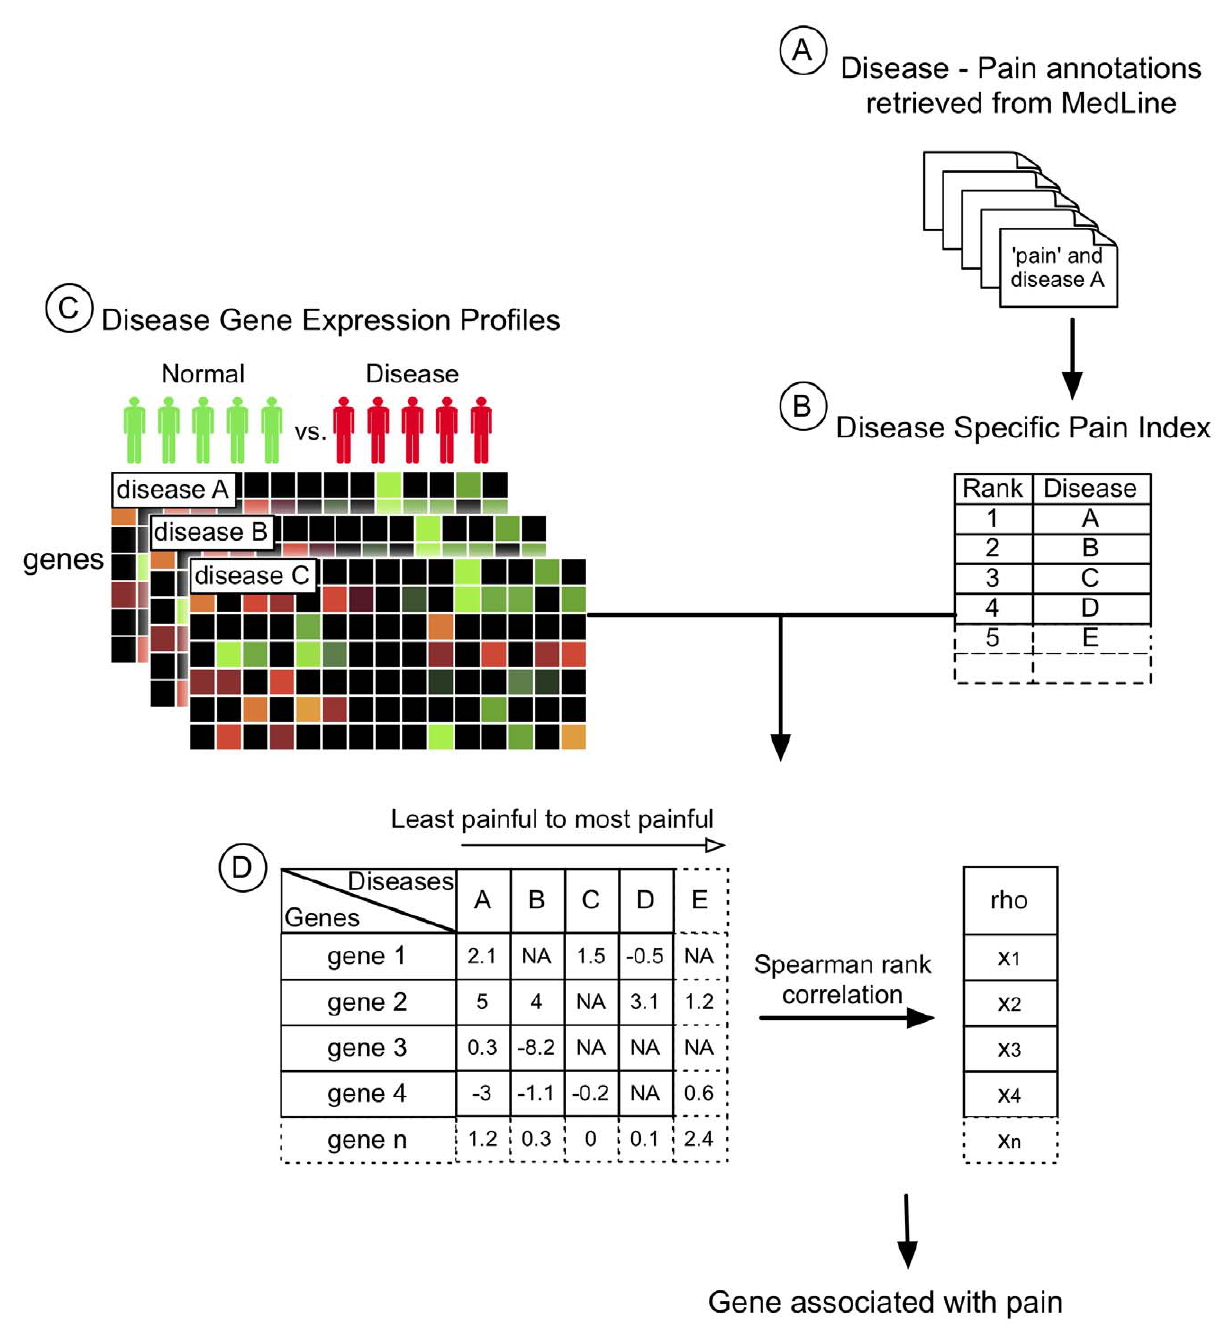
Figure 5. System-based approach to pain-gene candidate prioritization. (A) Publications annotated with the MeSH term ‘‘pain’’[mh] in conjunction with a disease MeSH term were retrieved from MEDLINE. (B) The co-citation ratio (see Materials and Methods) established a disease- specific pain index (DSPI) representing the relative painfulness of a disease compared to others. (C) The disease-associated experiments publicly available from GEO and AE were retrieved and significantly differentially expressed genes were extracted in a disease-specific manner. (D) Disease gene lists were organized according to the DSPI from highest to lowest. The gene expression fold change was correlated with the disease ordering to determine significant associations between gene expression patterns and the pain index. Genes were ranked according to their Spearman rank correlation coefficient (rho) and p-values corrected for multiple hypothesis testing.